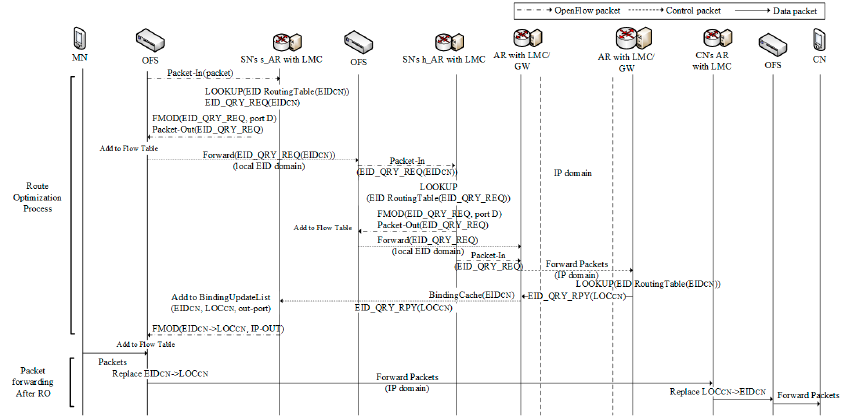
Figure 3. Packet forwarding after route optimization.